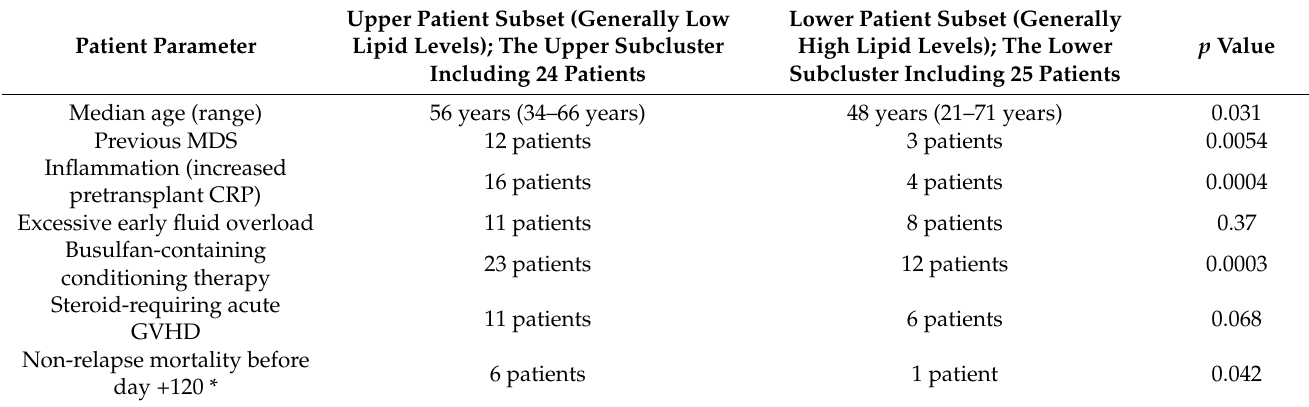
Table 4. A comparison of the two contrasting patient subsets identified in the hierarchical cluster analysis of total lipid levels (from Figure 1), and a comparison of the upper main subcluster (the 24 patients indicated by purple color in the right part of Figure 1, with generally low levels of lipids) and the lower subcluster (the 25 patients indicated by brown color to the right in the lowest part of Figure 1 and with generally high levels of lipids). For categorized data, we used the Fisher’s test, and for continuous data we used the Mann–Whitney U test for comparison of these two patient subsets; the p values are indicated in the right column of the table.